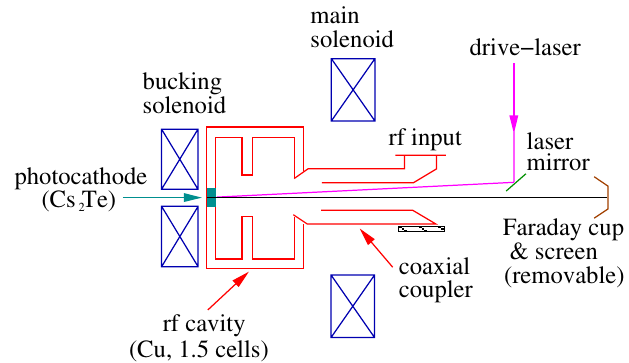
FIG. 3. (Color) Schematic view of the PITZ gun. To ensure axial symmetry for the gun cavity, a coaxial coupler is used. The main solenoid is located further downstream, and therefore the field at the cathode is relatively weak compared to the FNPL case. The bucking solenoid field is concentrated near the cathode only.